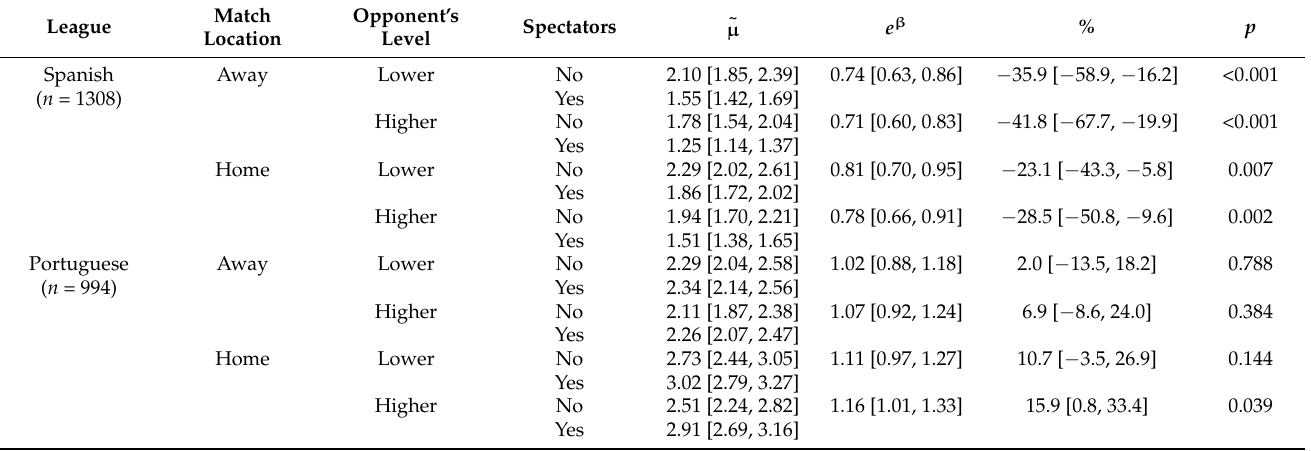
Table 4. Effect of playing with spectators on the number of set-pieces shot in different leagues and competitive